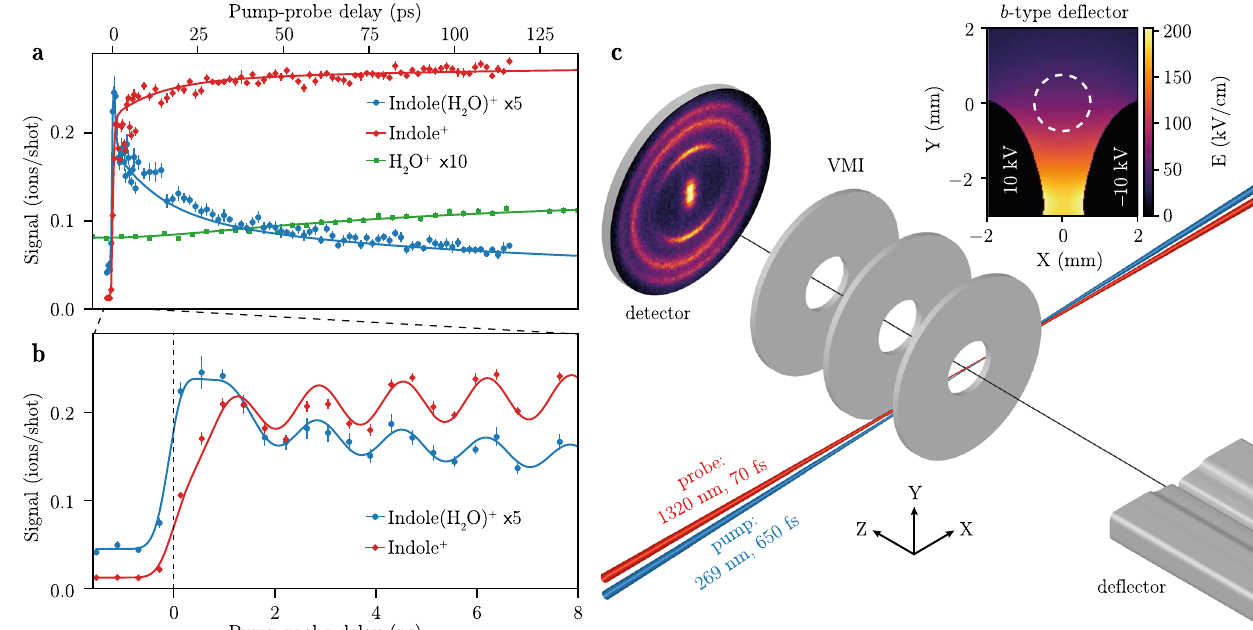
de fl ector and a velocity-map imaging (VMI) detector. A pump laser electronically excited indole(H 2 O), and a delayed probe laser ionised the reaction products. See Methods for details. The inset shows a cross section of the de fl ector: colours indicatetheelectric fi eldstrength E andthewhitedashedcircleindicateswherethe direct molecular beam passes through the de fl